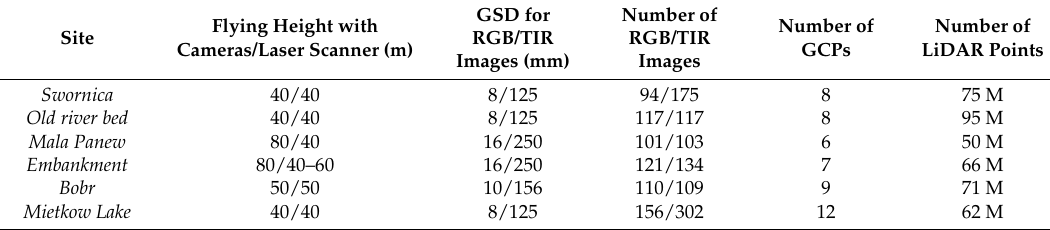
Table 2. The collected data.